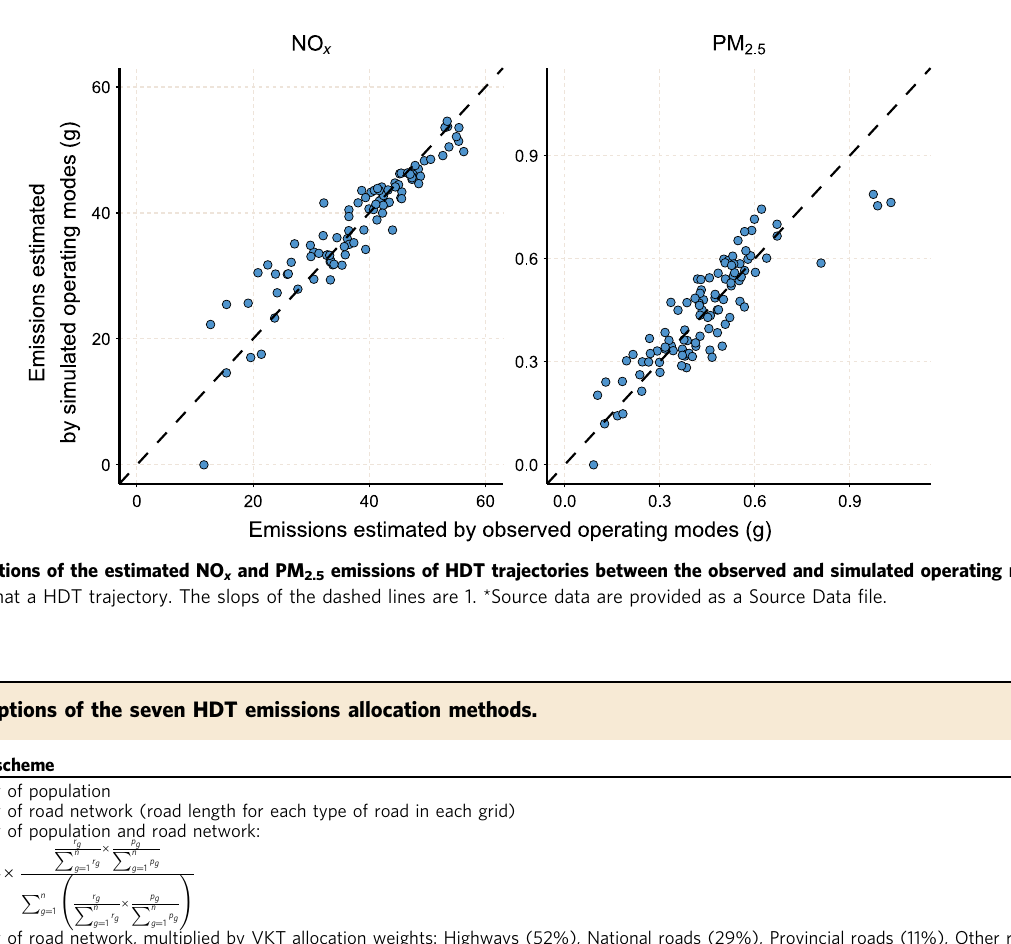
Density of road network, multiplied by VKT allocation weights: Highways (52%), National roads (29%), Provincial roads (11%), Other roads (8%) M4-2 16 Density of road network, multiplied by VKT allocation weights: Highways (39%), National roads (25%), Provincial roads (19%), Other roads (17%) M4-3 b Density of road network, multiplied by VKT allocation weights: Highways (58%), National roads (19%), Provincial roads (11%), Other roads (12%) M4-4 Density of road network, multiplied by VKT allocation weights: Highways (52%), National roads (18%), Provincial roads (19%), Other roads (11%) a e i , g is the 0.01 ˚ gridded HDT emissions for pollutant i and grid g . E i is the total amountof HDT emissions forpollutant i in the BTH region. p g is the numberof populationsin grid g . r g is the lengthof the road in grid g . b The VKT allocation weights of M4-3 and M4-4 are the optimized results based on M4-1 and M4-2 by machine learning 32